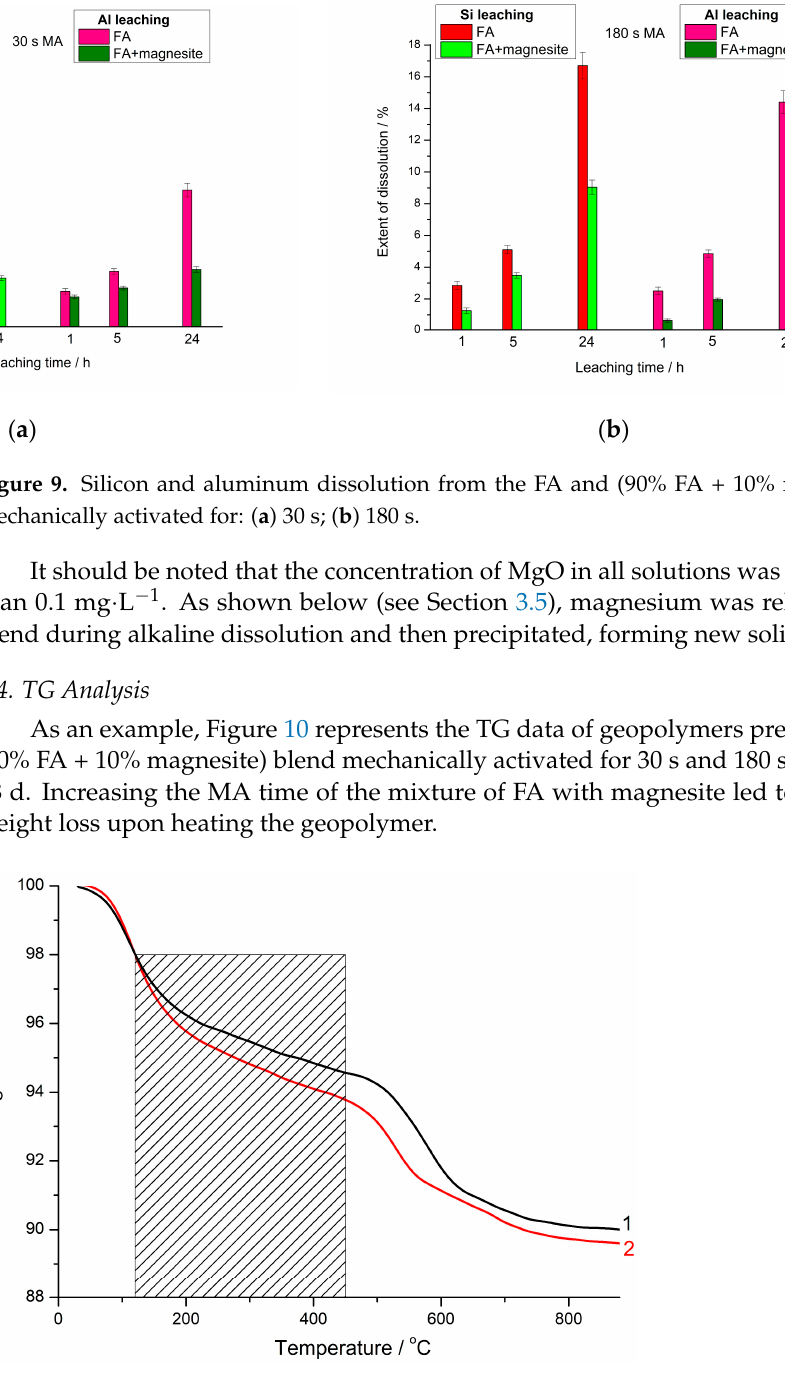
Figure 10. Thermogravimetric (TG) curves of the geopolymers based on the (90% FA + 10% magnesite) blend milled for: 1—30 s, 2—180 s. Curing time was 28 d. The shaded area corresponds to the removal of water tightly bound with the geopolymer gel.